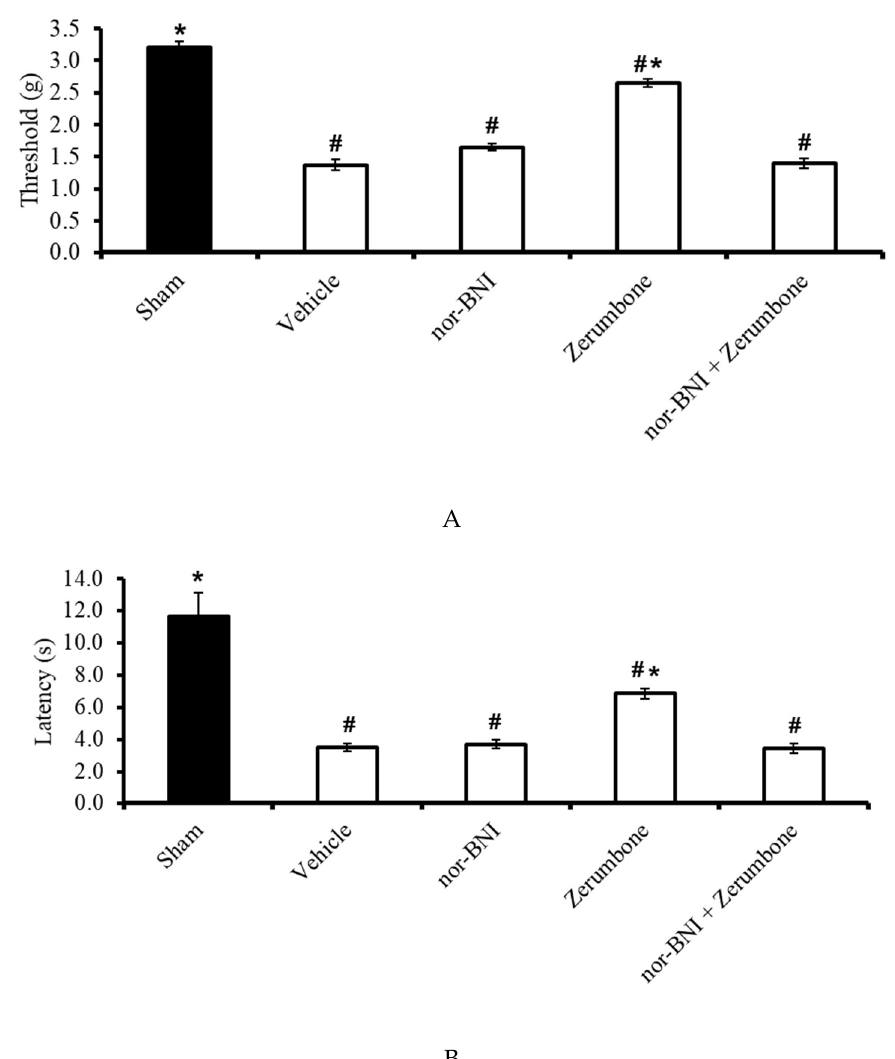
Figure 8. E ff ect of zerumbone (10 mg / kg; i.p.) and pre-treatment with a selective κ -opioid receptor antagonist (nor-binaltorphamine, nor-BNI; 10 mg / kg; s.c.) on the responses toward ( A ) mechanical allodynia and ( B ) thermal hyperalgesia on CCI-induced neuropathic pain in mice. Each column represents the mean ± SEM; n = 8 mice per group. Note: # significantly di ff erent ( p ≤ 0.05) than sham group; * significantly di ff erent ( p ≤ 0.05) than vehicle group (one-way ANOVA followed by Tukey’s post hoc test).